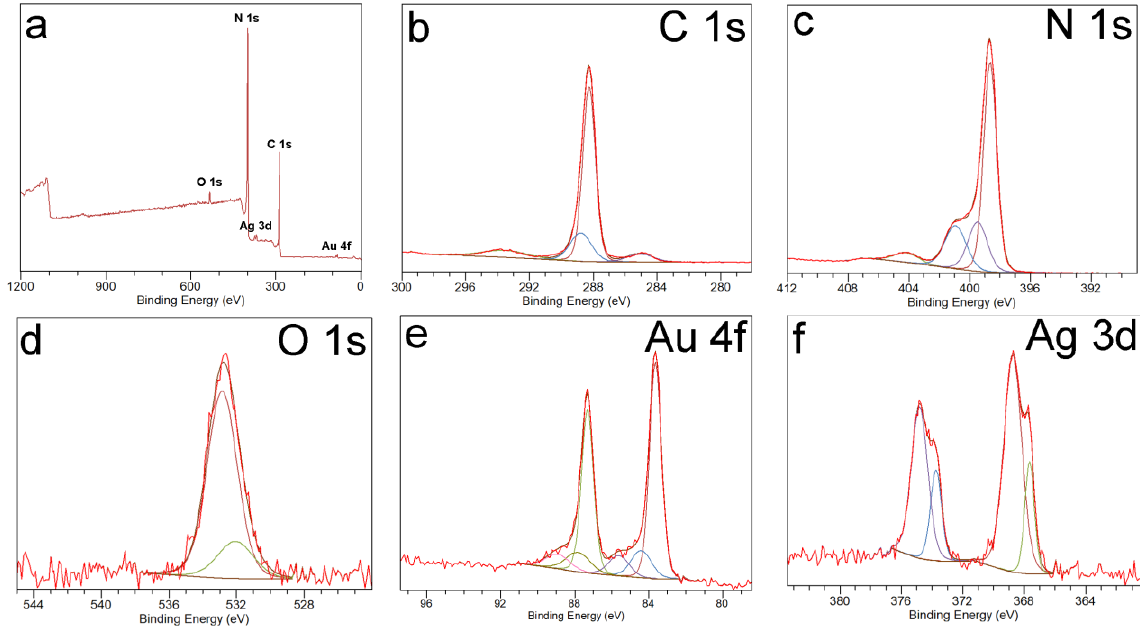
Figure 5. Wide XPS spectrum for AuAg-g-C 3 N 4 3 nanohybrid ( a ). High-resolution XPS spectra for C 1s ( b ), N 1s ( c ), O 1s ( d ), Au 4f ( e ) and Ag 3d ( f ).